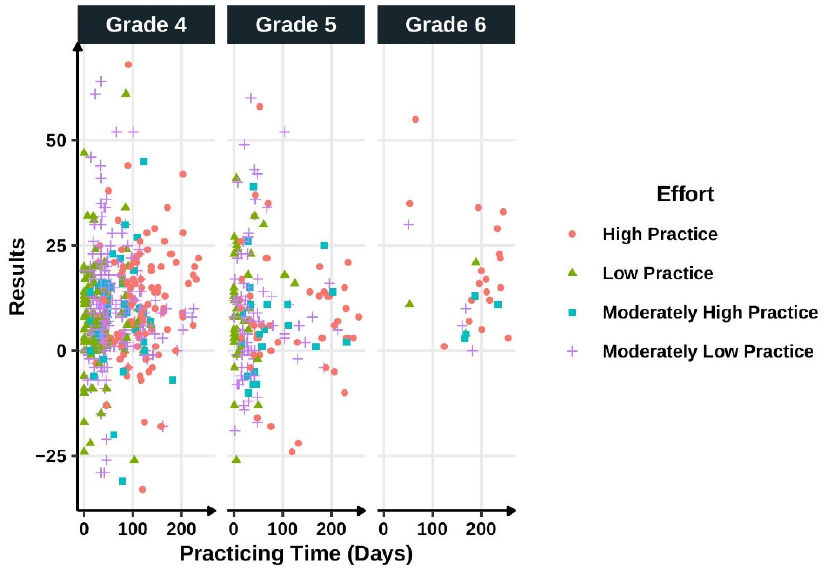
Figure 3. Clusters of effort-performance.